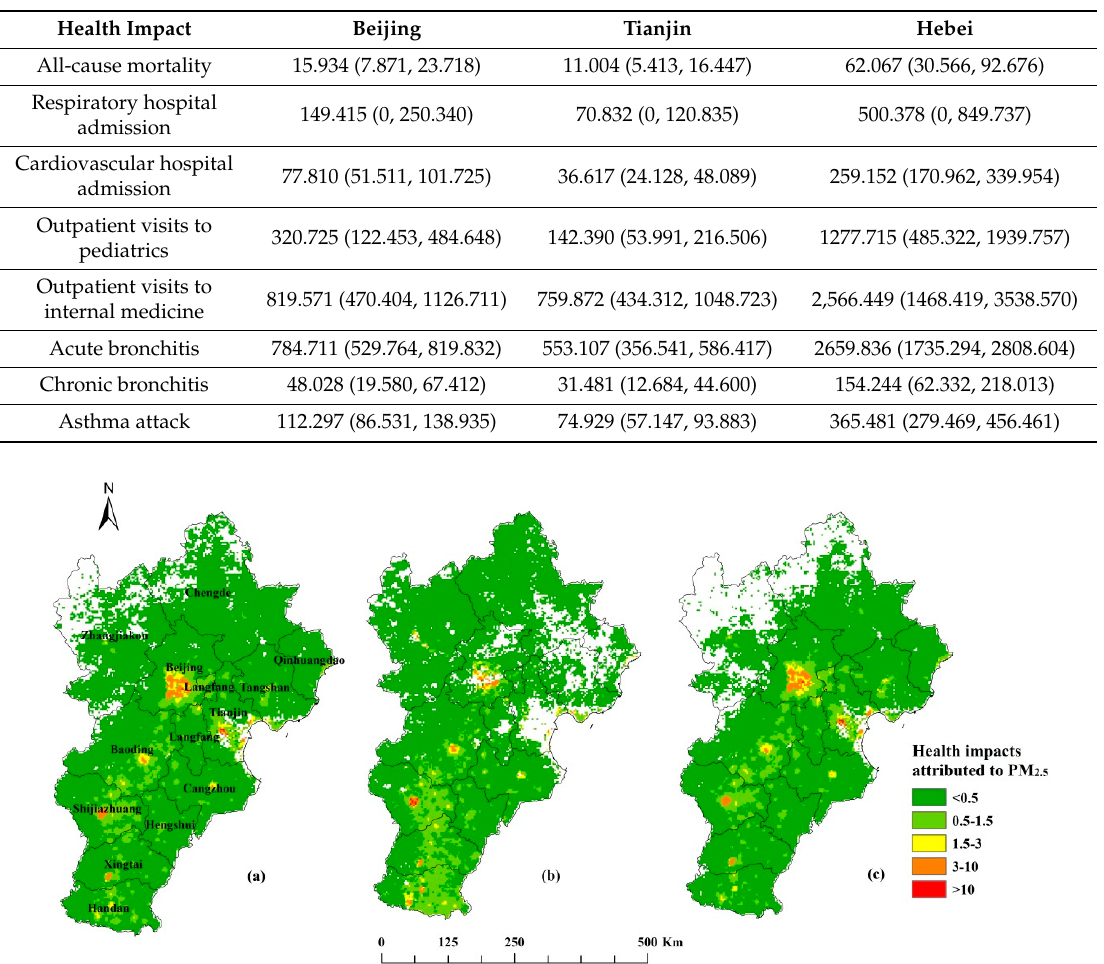
Table 4. Estimates of the cases (and 95% CI) attributable to PM 2.5 pollution (C 0 = 35 µ g / m 3 ) (Unit: Thousand cases).